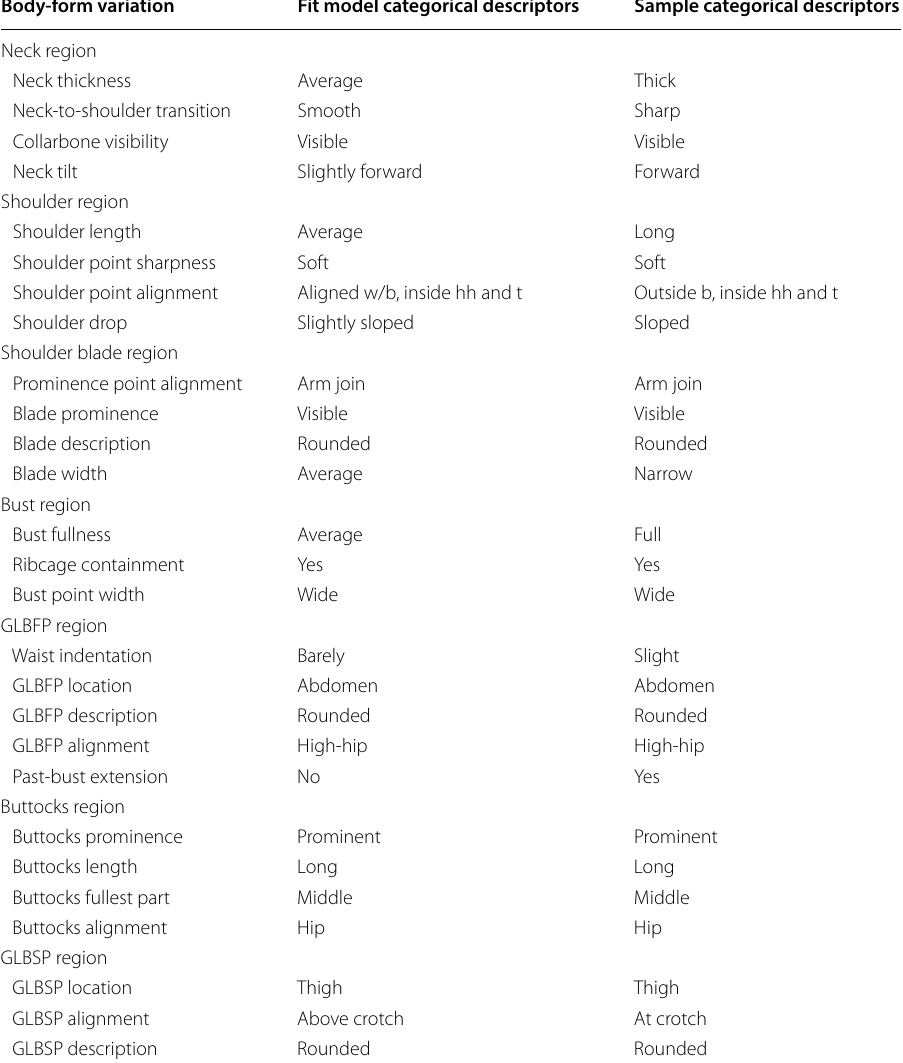
Table 6 Body-form variations—fit model vs. most common variations in the sample Body-form variation Fit model categorical descriptors Sample categorical